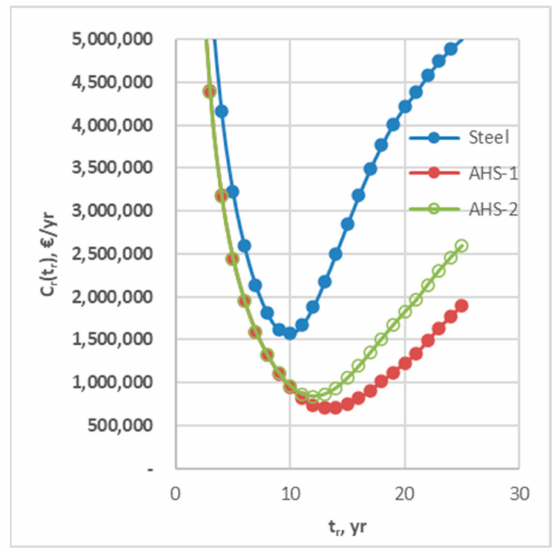
Figure 10. Total cost of repair per unit of